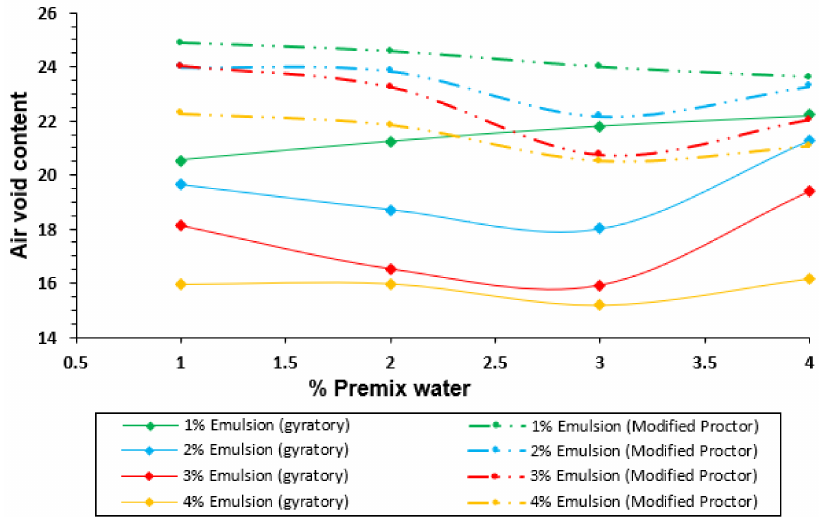
Figure 7. Air void content for different emulsion content in samples compacted with the gyra- tory